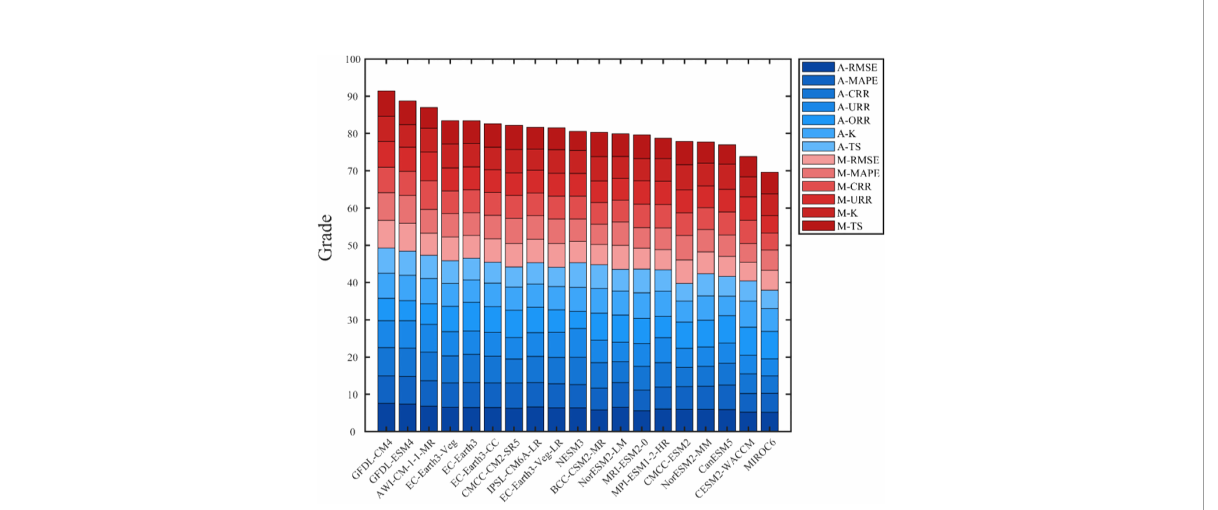
FIGURE 3 Evaluation scores for the 19 CMIP6 models. The thirteen color blocks from bottom to top correspond to thirteen weighted scoring indicators: annual-RMSE, annual-MAPE, annual-CRR, annual-URR, annual-ORR, annual-k, annual-TS, mean-RMSE, mean-MAPE, mean-CRR, mean-URR, mean-k, and mean-TS.